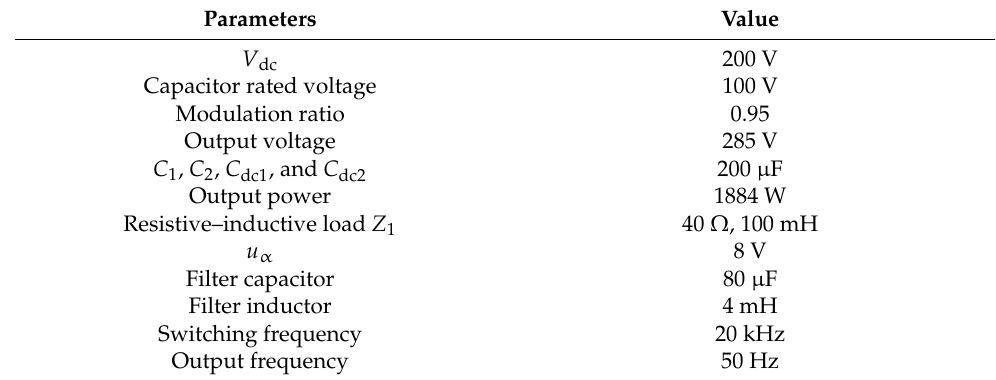
Table 3. Parameters of the proposed three-phase